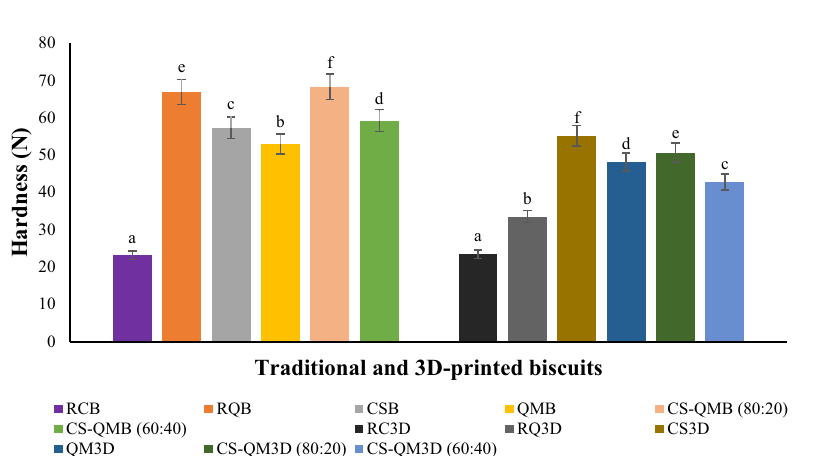
Figure 3. Texture (hardness) properties of the raw, cowpea sourdough, and quinoa malt whole and multigrain biscuits. Averages of the hardness depicted as bars with superscripts indicate significant differences ( p ≤ 0.05). RCB raw cowpea biscuit, RQB raw quinoa biscuit, CSB cowpea sourdough biscuit, QMB quinoa malt biscuit, CS-QMB (80:20) 80% cowpea sourdough and 20% quinoa malt biscuit, CS-QMB ( 60:40 ) 60% cowpea sourdough and 40% quinoa malt biscuit, 3D three-dimensional, RC3D raw cowpea 3D-printed biscuit, RQ3D raw quinoa 3D-printed biscuit, CS3D cowpea sourdough 3D-printed biscuit, QM3D quinoa malt 3D-printed biscuit, CS-QM3D (80:20) 80% cowpea sourdough and 20% quinoa malt 3D-printed biscuit, CS-QM3D (60:40) 60% cowpea sourdough and 40% quinoa malt 3D-printed